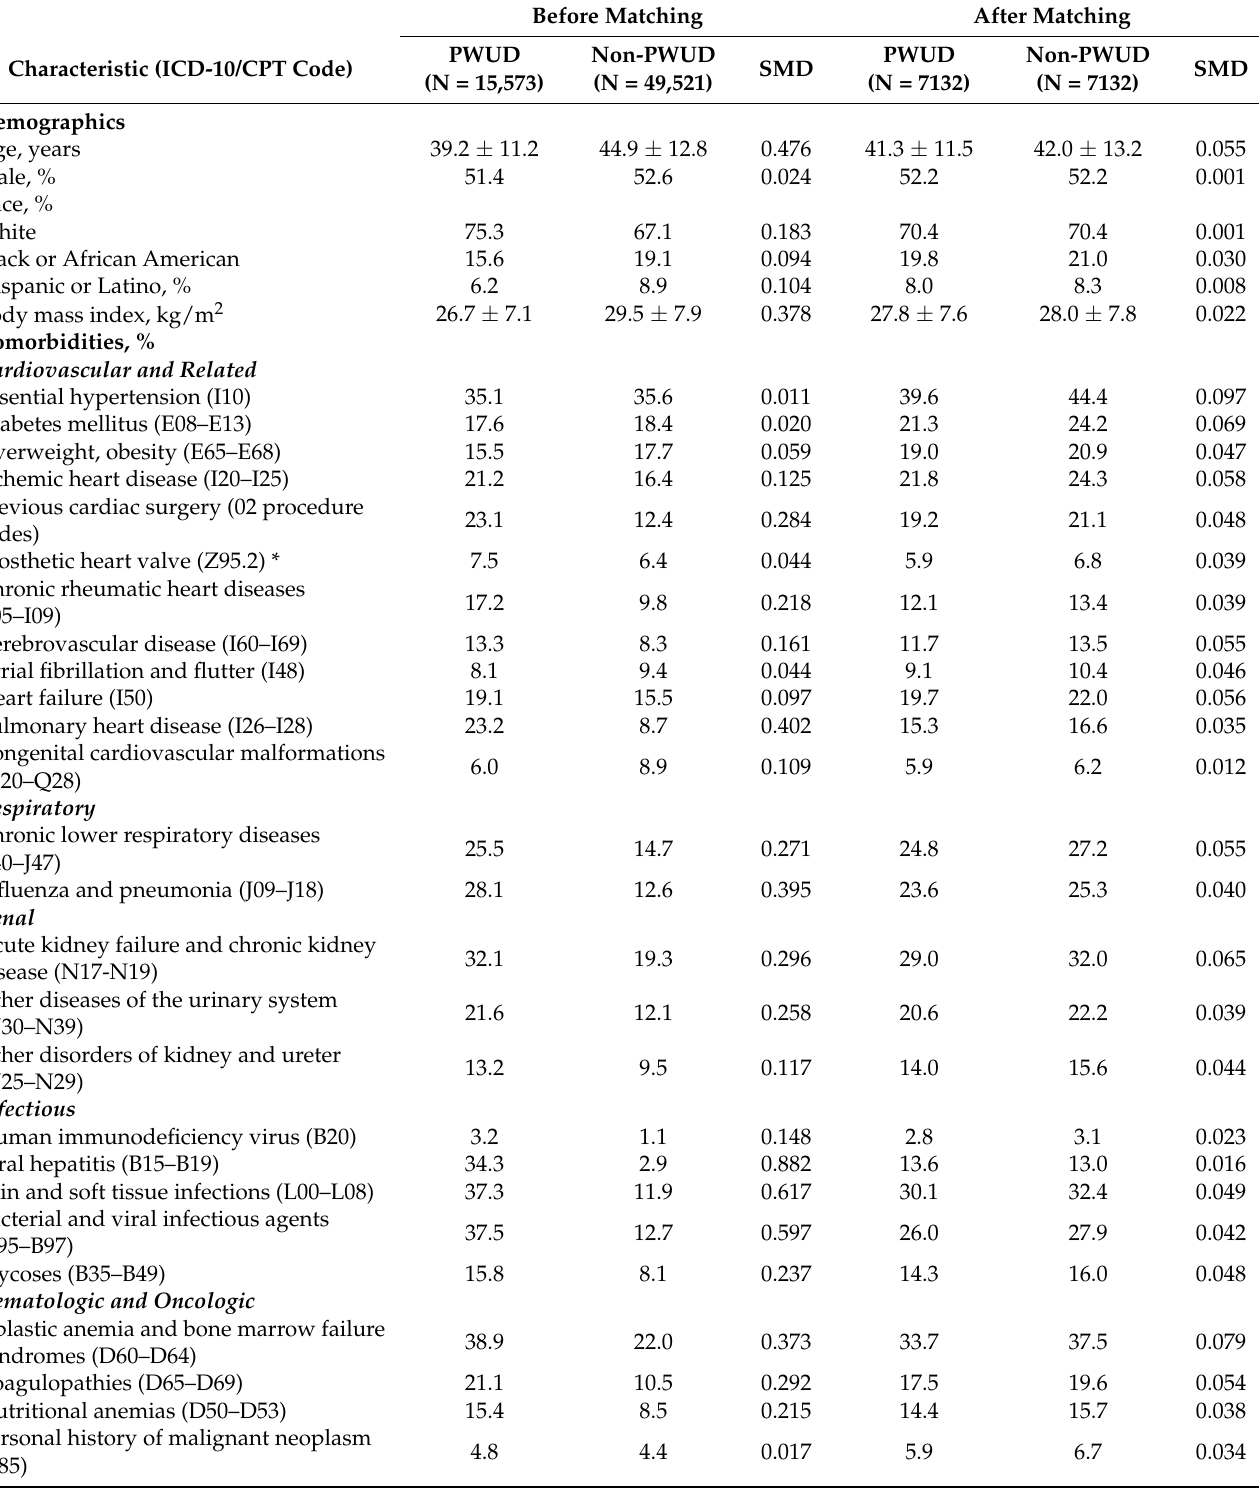
Table 1. Baseline characteristics at or before the time of infective endocarditis diagnosis before and after propensity score